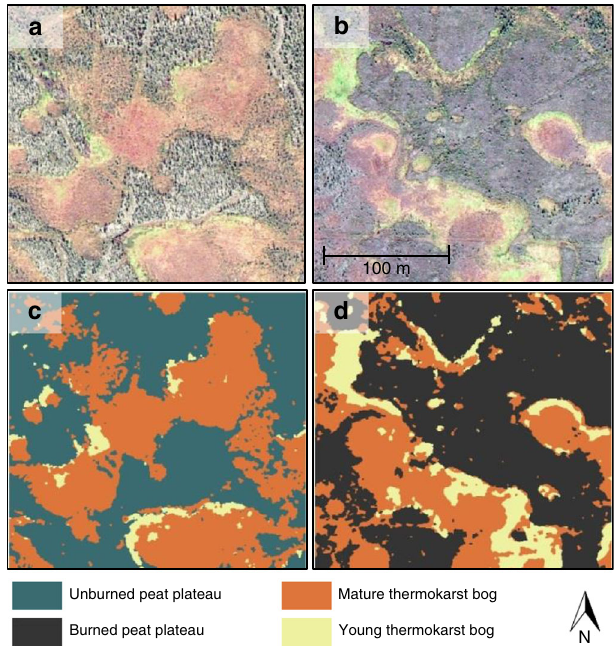
Fig. 4 Classi fi cation of peat plateau, young thermokarst bog, and mature thermokarst bog using high resolution satellite imagery in peatlands partially affected by historical wild fi res. a and b Examples of satellite imagery (WorldView-2, 0.6 m resolution) for 250 × 250 m sections within unburned and burned peatland parts, respectively. Satellite images were acquired in 2011, the burn occurred in 1987. c and d Examples of supervised classi fi cation of the unburned and burned sections,